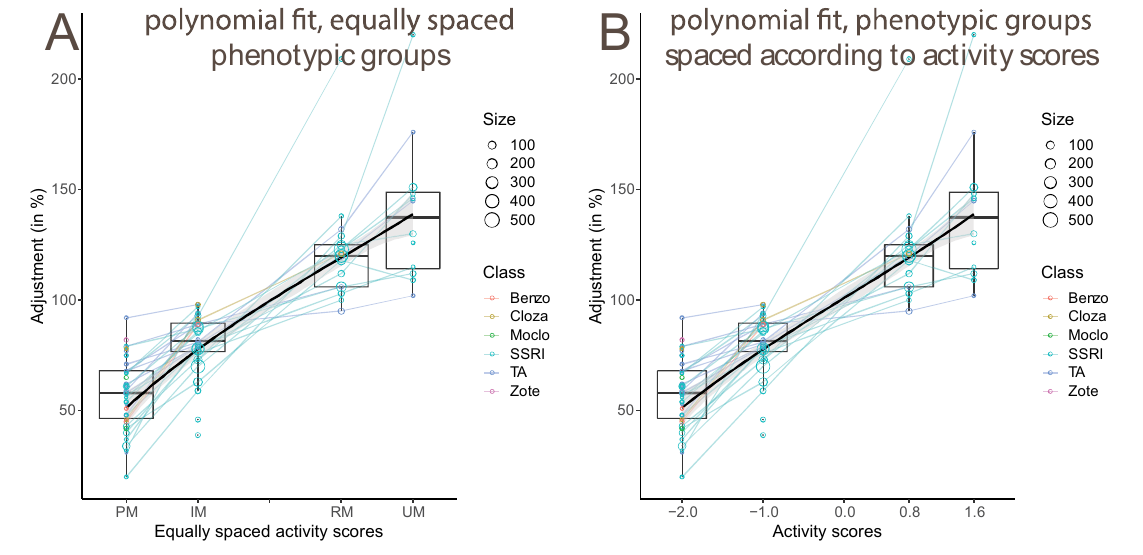
Figure 1. ( A ) Estimated dose adjustments were plotted as a function of phenotype, coded in expression grades of equal intervals from the PM to the UM phenotypes. The fitted line is a cubic polynomial, and shows the effect to be almost linear, with a slight inflection downwards in the middle. ( B ) The same plot, with the phenotypic groups spaced at the intervals of the estimated activity scores. The fitted line is a cubic polynomial again, this time showing a linear fit.